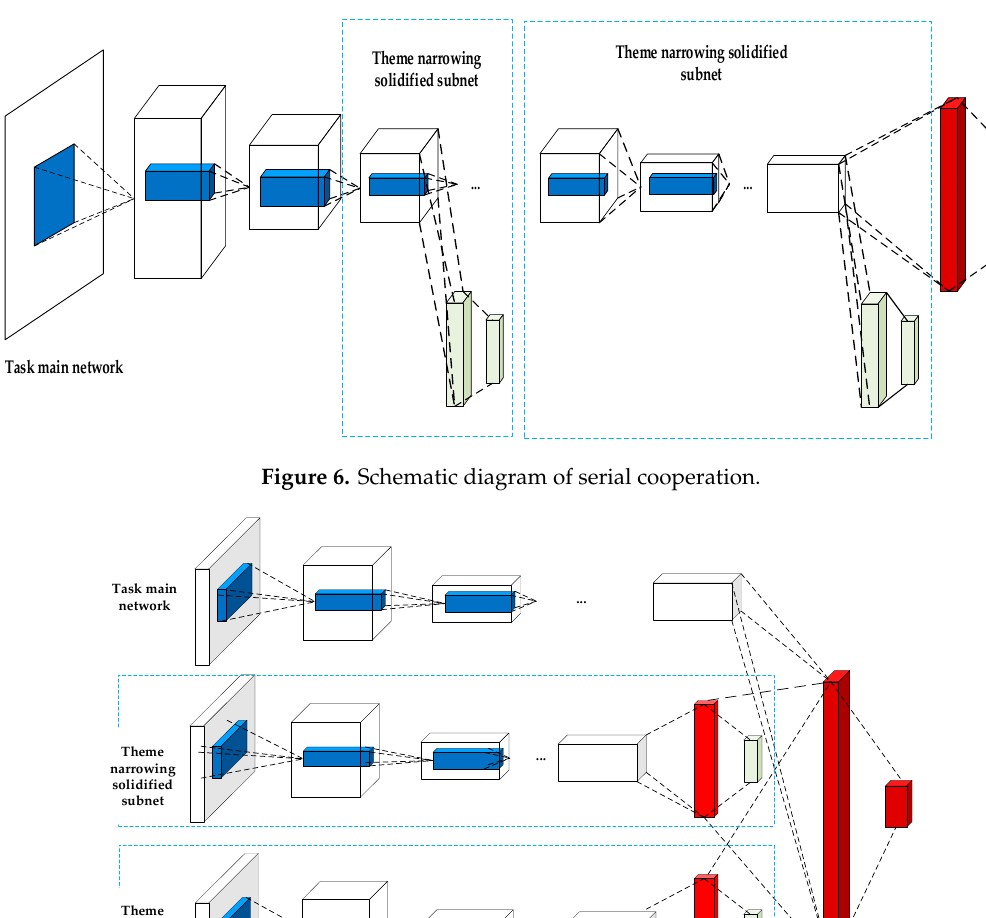
Figure 7. Schematic diagram of parallel cooperation.